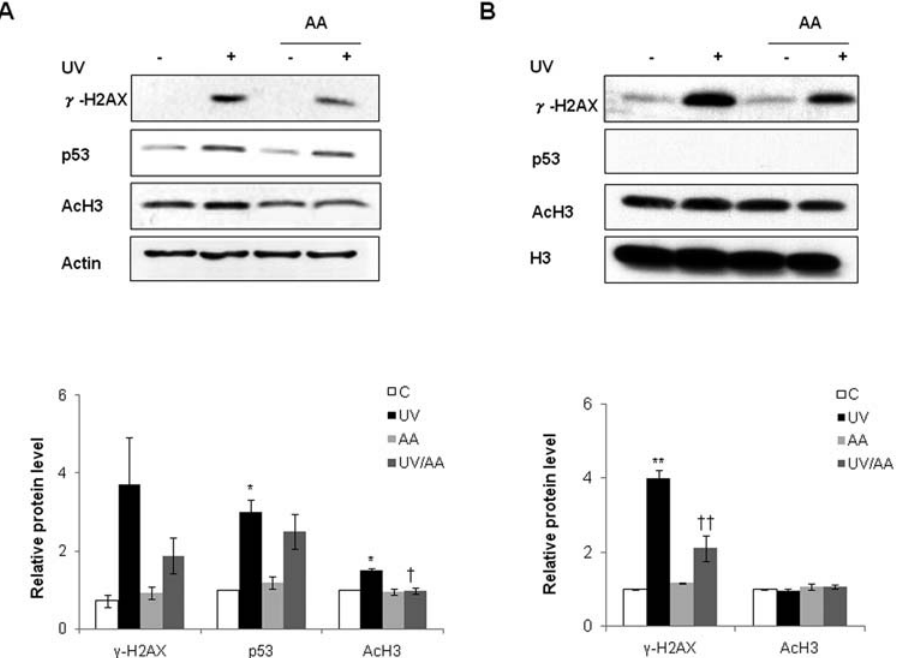
Figure 5. p300HAT mediates UV-induced p53 expression and histone modification. A and B, U2OS (p53 wt ) and SAOS-2 (p53 2 / 2 ) cells were UV-irradiated and post-treated with 7.5 m M AA for 1 h. c -H2AX, p53, and acetyl-H3 in total cell lysates were analyzed by western blotting ( upper panels ). Bar graphs ( lower panels ) show quantitative analysis of scanning densitometric values of c -H2AX, p53 and acetyl-H3 as ratios to b -actin and histone H3 expression, which were used as loading controls. C: control, UV: UV-irradiated cells, AA: AA treated cells, UV/AA: UV irradiated cells incubated with AA. Values represent the mean 6 SEM of data from three independent experiments. *P , 0.05, **P , 0.01 vs. control; { P , 0.05, { { P , 0.01 vs.